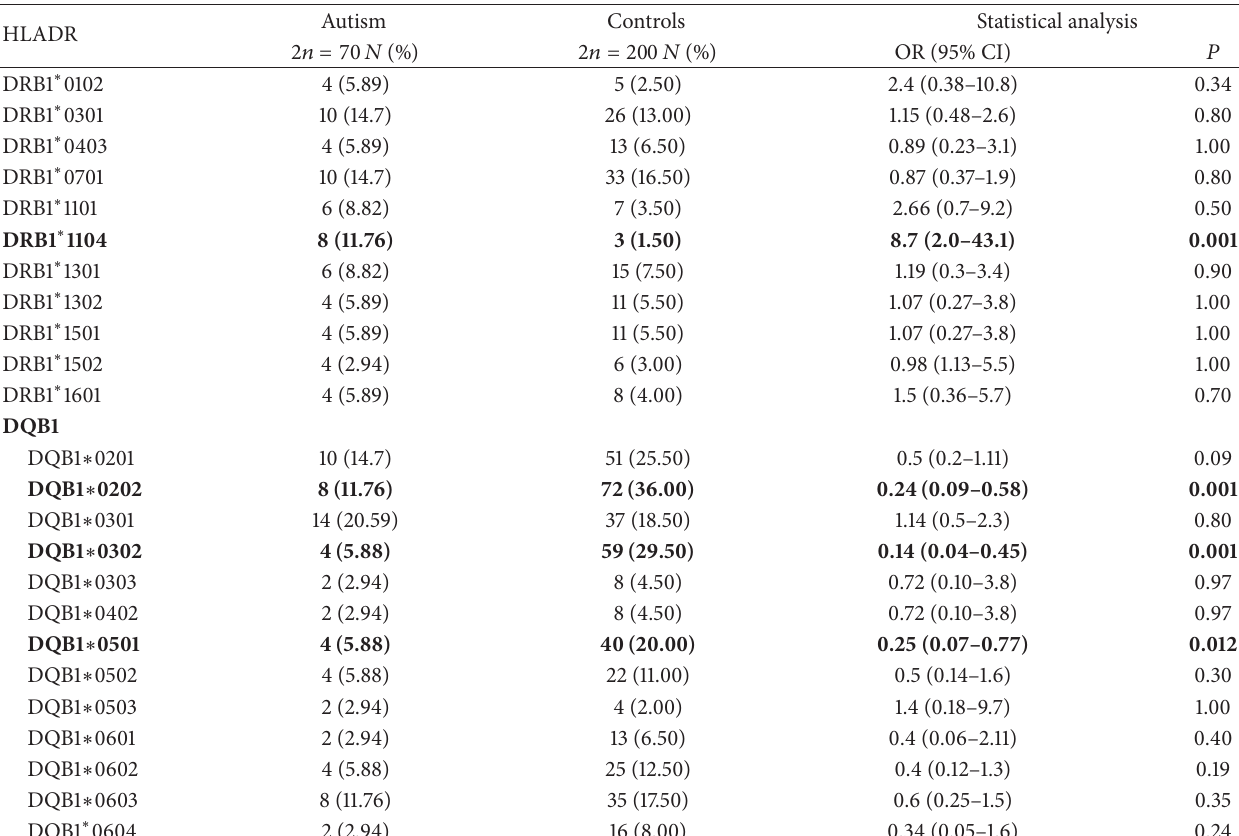
Table 2: The HLA-DRB1 ∗ and DQB1 ∗ alleles frequencies in autistic children and controls.